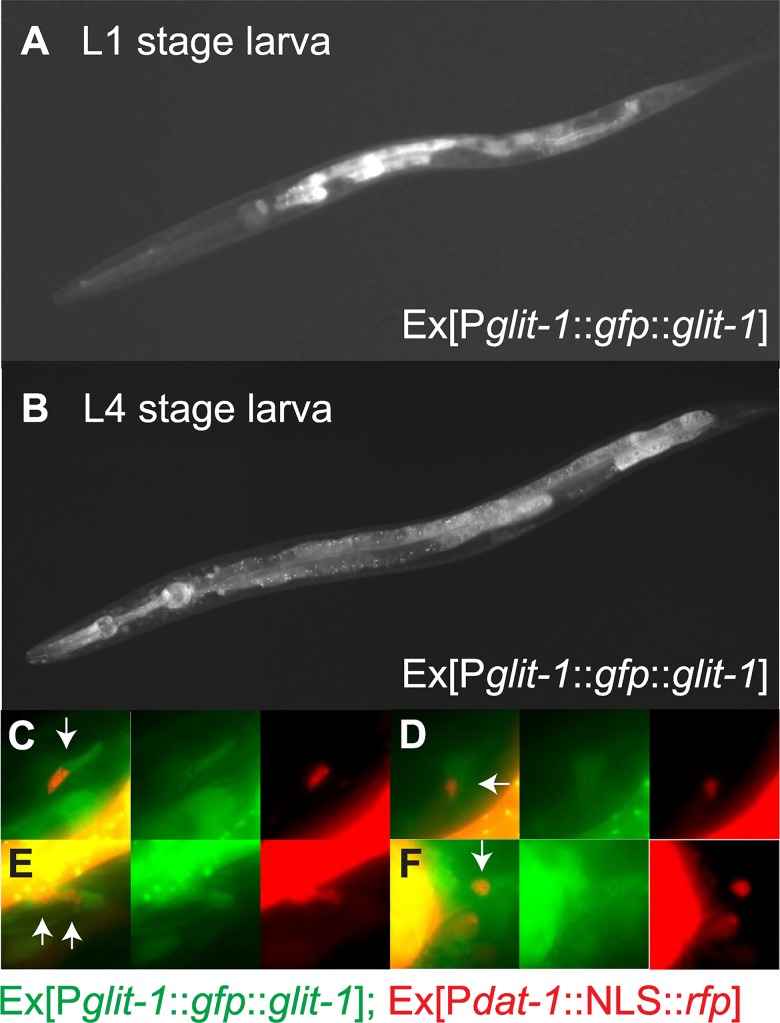
glit-1 is expressed in the pharynx, the intestine and in several cells in the head including dopaminergic neurons.(A) L1 stage larva expressing Ex[Pglit-1::gfp::glit-1]. (B) L4 stage larva expressing Ex[Pglit-1::gfp::glit-1]. This image was generated from three individual images in ImageJ using the Stitching plugin [60]. (C)–(F) Close up of dopaminergic neurons of the same L4 stage larva. The green channel shows expression of Ex[Pglit-1::gfp::glit-1]. The red channel shows expression of Is[Pdat-1::NLS::rfp;Pttx-3::mCherry] for labelling of dopaminergic neuron nuclei, as well as the pharynx muscle marker Ex[Pmyo-2::mCherry] and the body muscle marker Ex[Pmyo-3::mCherry] that were used for injections.